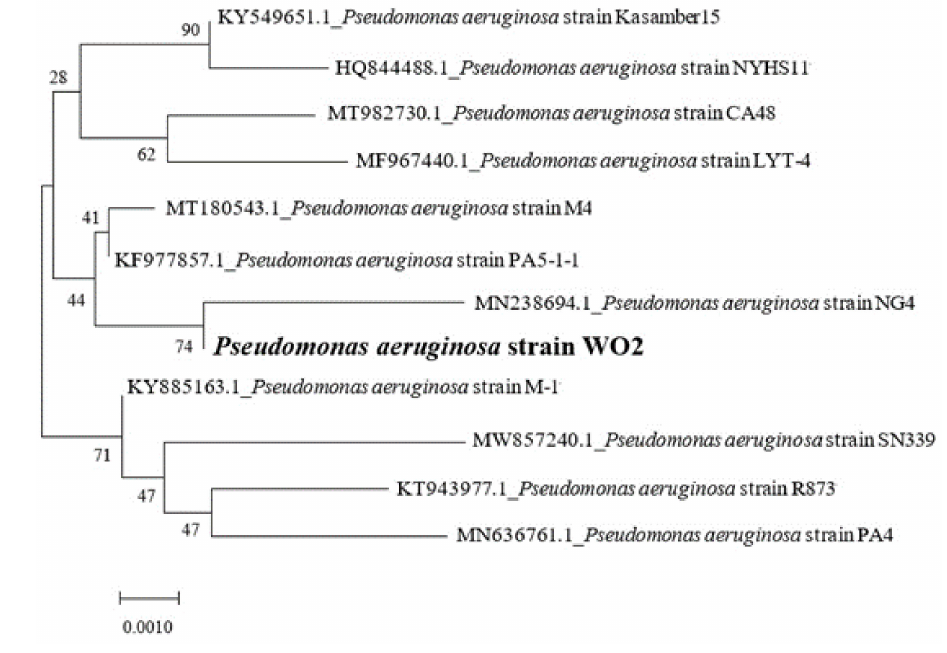
Figure 1. Phylogenetic tree of Pseudomonas aeruginosa WO2 based on the Neighbor-Joining